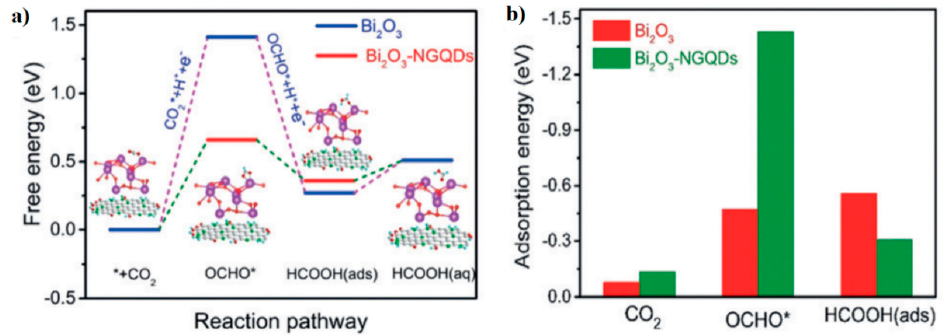
Figure 12. ( a ) Free-energy diagram and ( b ) adsorption energy of CO 2 , OCHO*, and HCOOH (ads) for Bi 2 O 3 and Bi 2 O 3 -NGQDs. Reproduced with permission